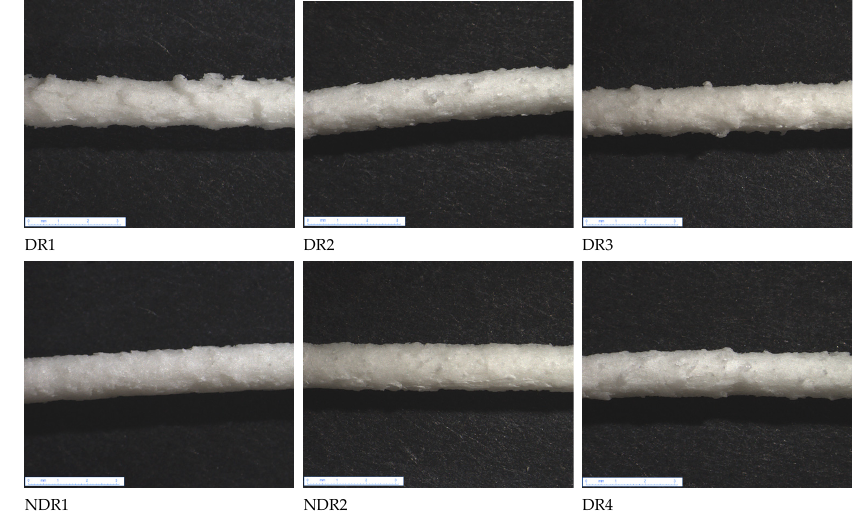
Figure 8. Amiodarone hydrochloride filaments under binocular microscope ×6. During filament production, in-process control allowed collecting different values of the filament diameter shown in Table 8. The filament maximum, minimum, average di- ameter, and relative standard deviation (RSD) of diameter were equivalent for all fila- ments produced by HME. This showed that regulation works correctly for all batches. Average belt speed was lower for NDR1 and NDR2 batches (5 mm/s versus 7 mm/s for the other batches). This value corresponded to the extrudate flow rate, which was linked to HME speed, force feeder speed, and powder flowability. However, from DR1 to NDR2 batches, extruder and force feeder speed were set constant at 25 and 3.5 RPM. Variation of average belt speed was the consequence of powder flowability modification. It has been shown previously that the storage conditions modify the quantity of wa- ter contained in the powders. The lowest filaments rate of the regulation (and therefore, the lowest output rate) was observed for the non-dried powders (NDR1 and NDR2); these had the highest quantity of water. Indeed, the adsorbed water increased capillary interac- tion, which reduced the flow capacity of the powders [18,19]. This, therefore, explains storage conditions influence the regulation speed of the stericut system. A change in flow rate can alter the physical characteristics of the filament produced. This is why a dried batch (DR4) was manufactured with a reduced extrusion speed in order to obtain an average belt speed of around 5.4 mm/s, which was identical to the non- dried batches (NDR1, NDR2). The objective was to compare the influence of HME flow on the apparent density and morphology of these batches.